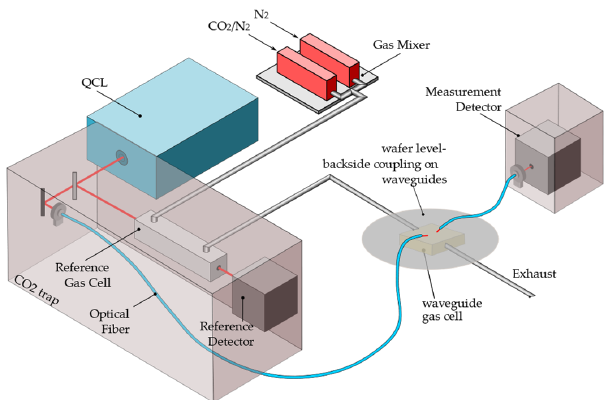
Figure 3. Experimental setup for wafer ‐ level measurements of the damping and confinement factor.